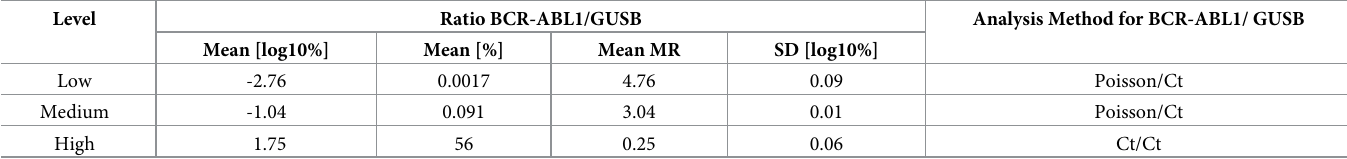
Table 3. Precision results for ratios